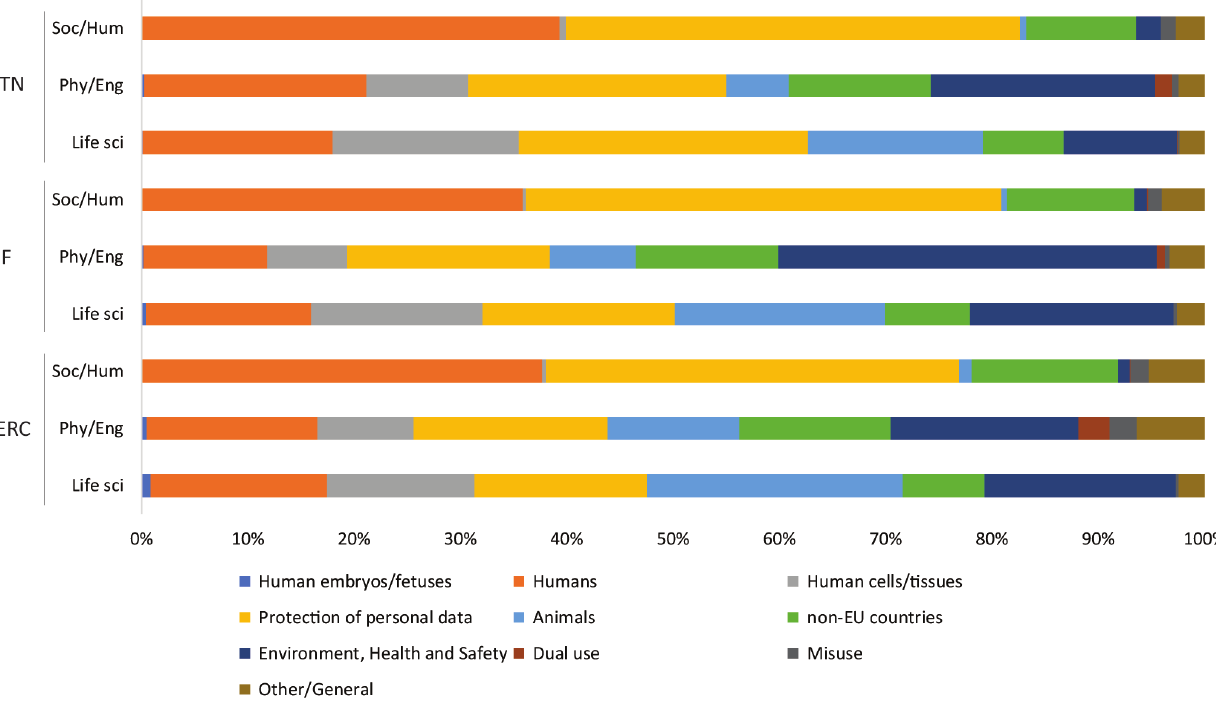
Figure 10. Distribution of ethics requirements identified by ethics experts, by research domain. ITN – Innovative Training Networks, IF – Individual Fellowships, ERC – European Research Council grants. The data are from years available in the SEP tool of the European Commission. Soc/Hum – Social Sciences and Humanities, Phys/Eng – Physical Sciences and Engineering, Life sci – Life Sciences.